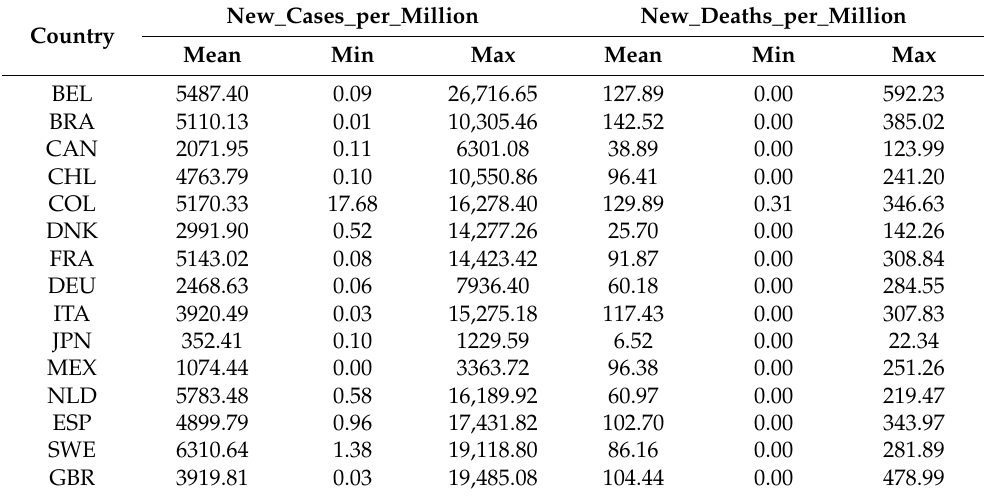
Table 1. Ranges of values of COVID-19